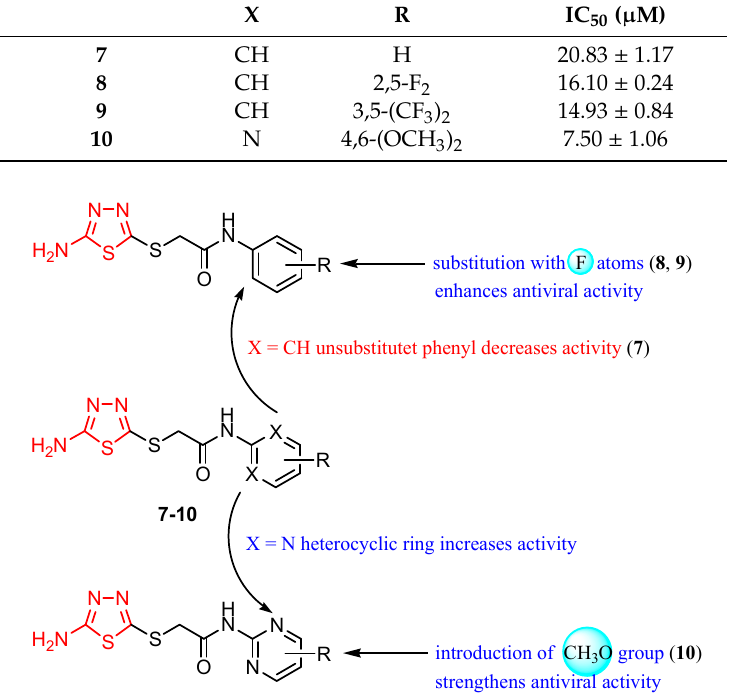
Figure 2. The influence of substituents of 1,3,4-thiadiazole derivatives 7 – 10 on anti-HIV activity.